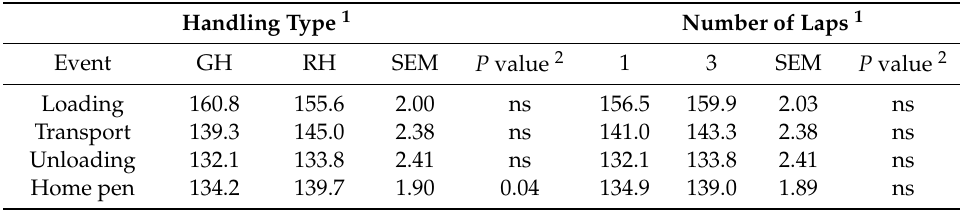
Table 4. Least square means of heart rate (bpm) by treatment and